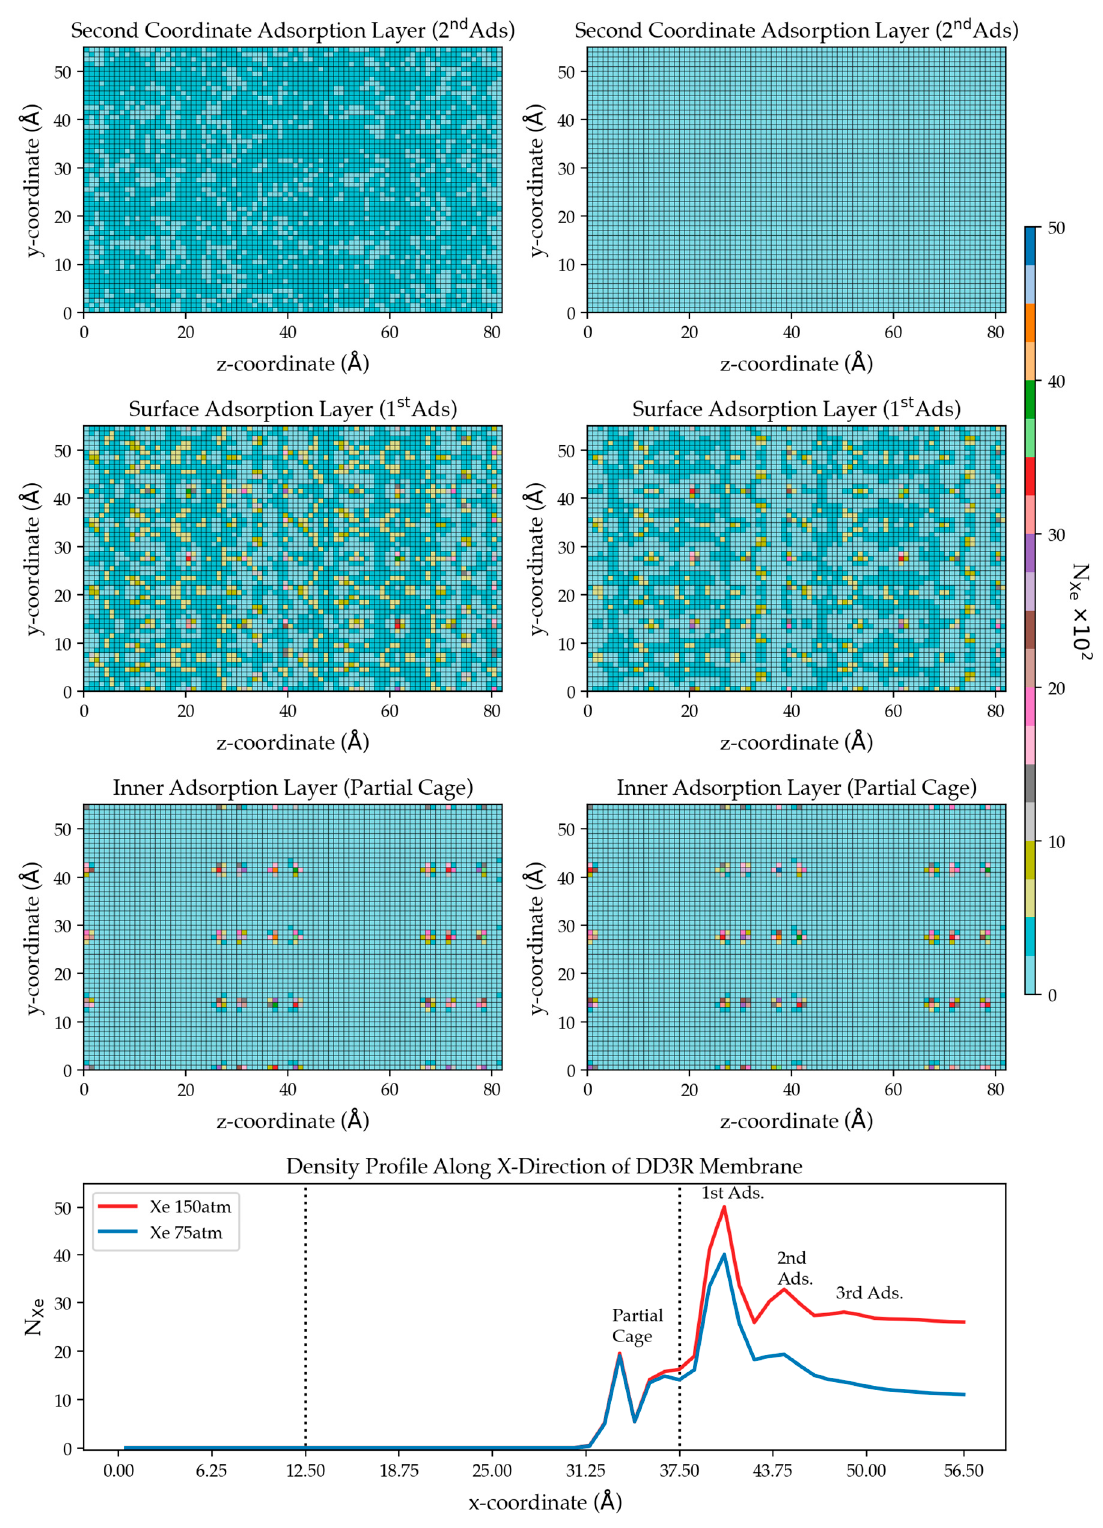
Figure 9. Two-dimensional density plots illustrating adsorption of Xe atoms on the membrane surface at two pressures using results of simulation (4) 75 atm ( right ) and (5) 150 atm ( left ). The top 2 plots correspond to the number density from the integrated peak of the secondary adsorption layer in Figure 8, followed by that of the surface adsorption peak, and the prominent peak inside the membrane. The bottom plot is a copy of Figure 8 as a reminder.